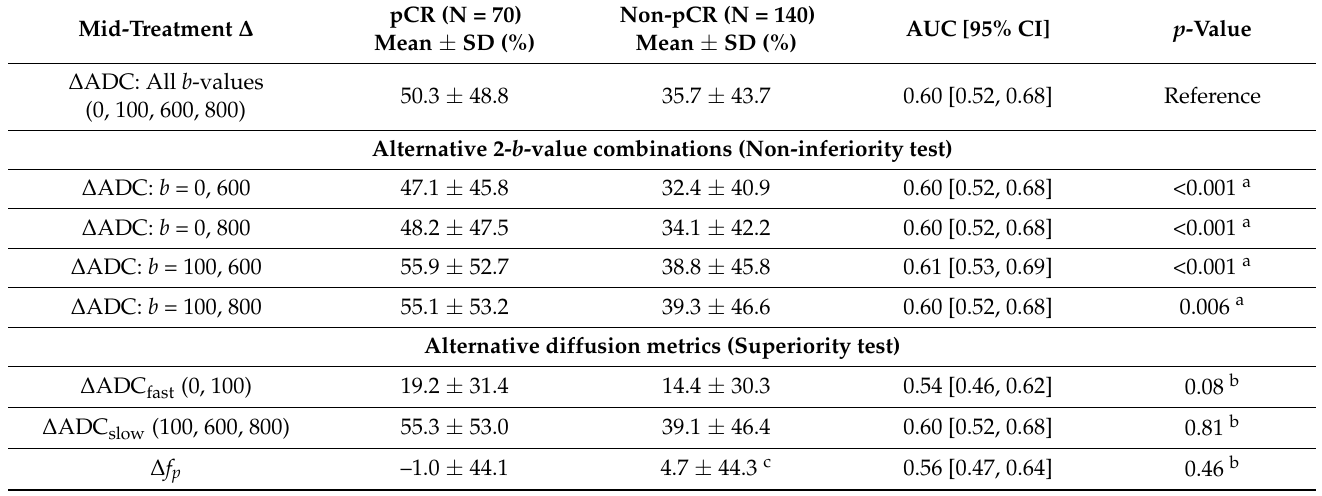
Table 3. Relative performance of mid-treatment percent change in alternate tumor ADC, f p metrics for predicting